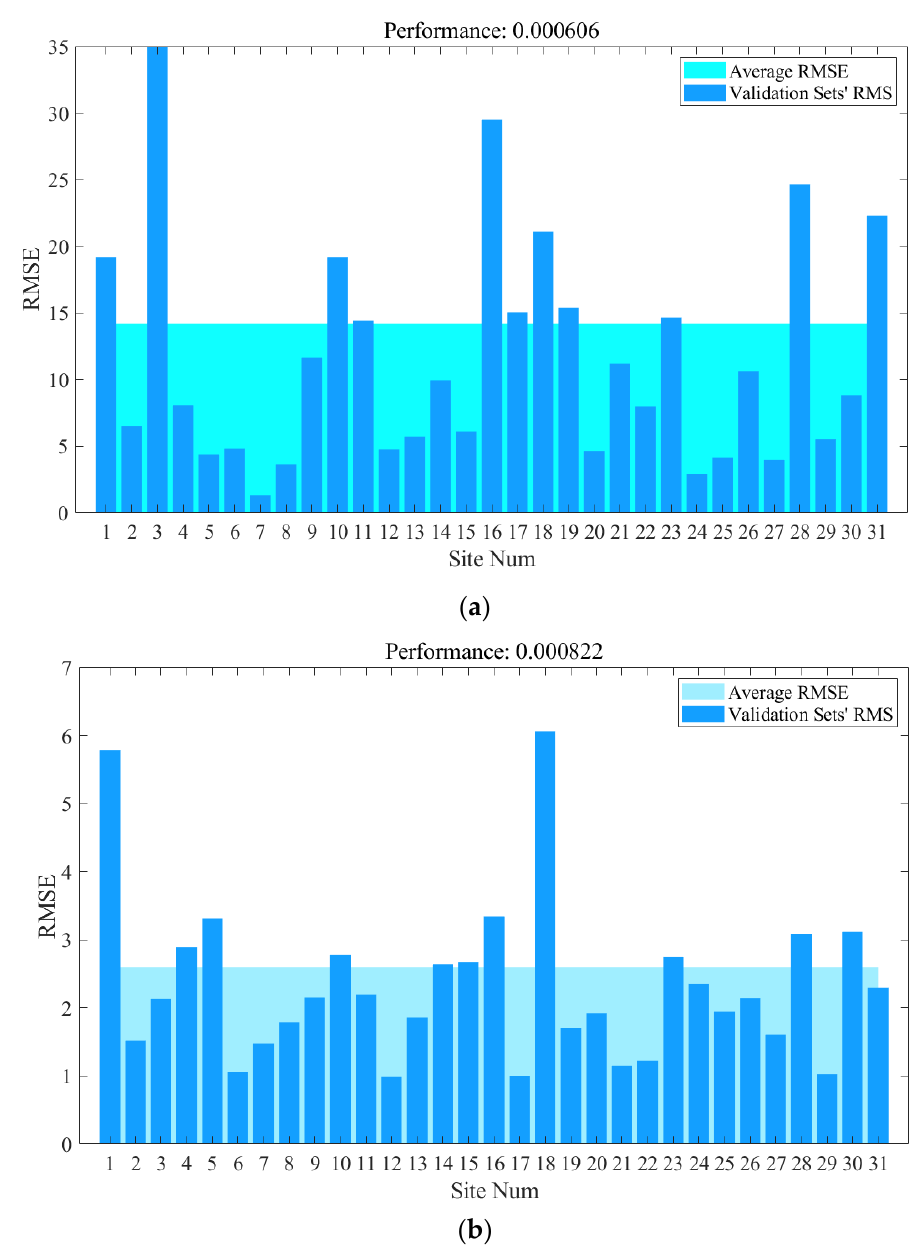
Figure 12. Example of overfitting: ( a ) the model’s RMSE when the performance index is 0.000606; and ( b ) the model’s RMSE when the performance index is 0.000822.